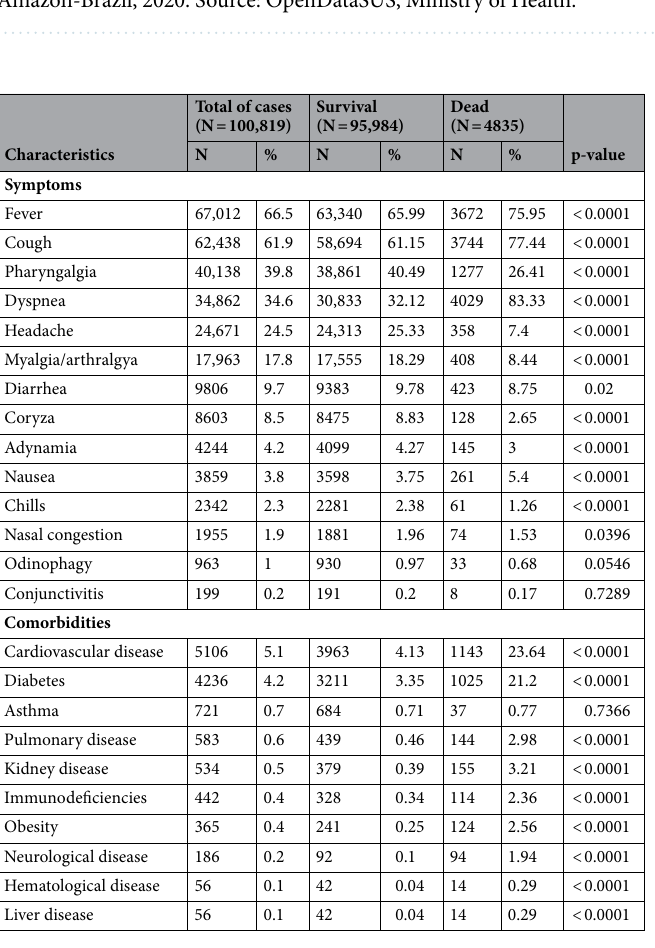
Table 1. Clinical characteristics of SARS-CoV-2 infected people in a region of the Brazilian Amazon, 2020. Source: OpenDataSUS, Ministry of Health. *G test.